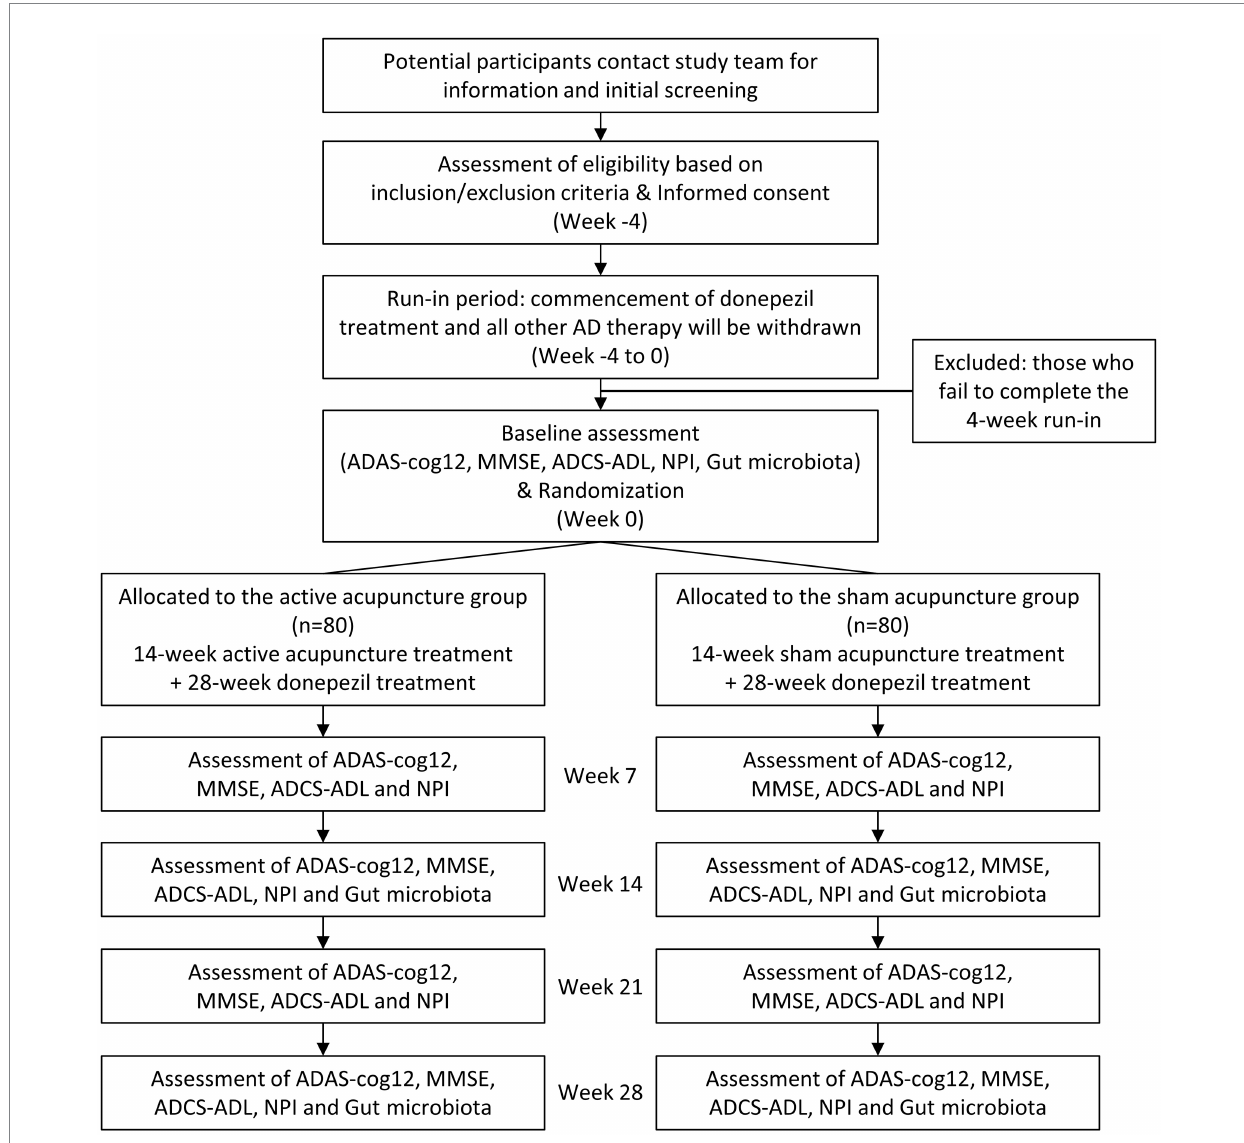
FIGURE 1 Flow diagram of the study protocol. ADAS-cog12, Alzheimer’s Disease Assessment Scale; MMSE, Mini-Mental State Examination; ADCS-ADL, the Alzheimer’s Disease Cooperative Study Activities of Daily Living; NPI, Neuropsychiatric